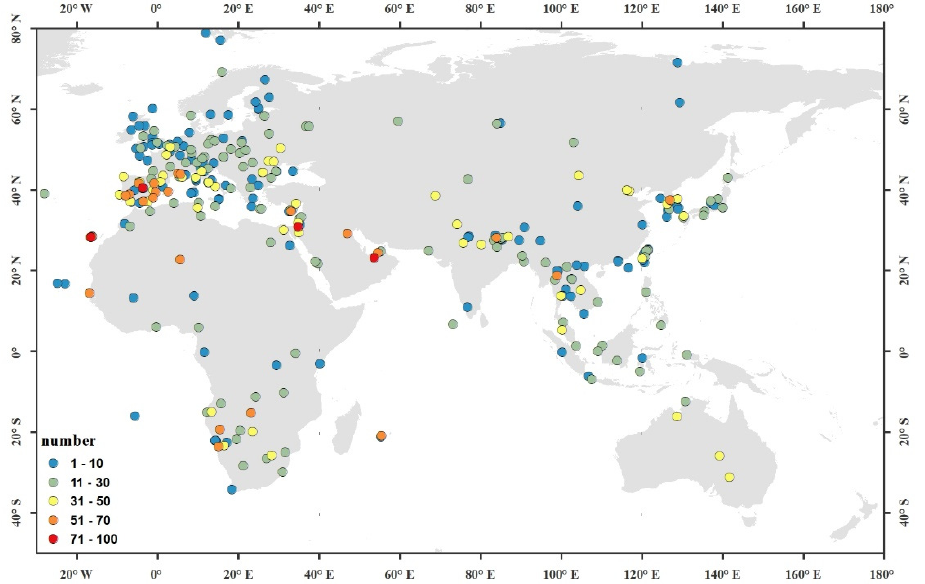
Figure 1. The number of collocated samples in each AERONET station.